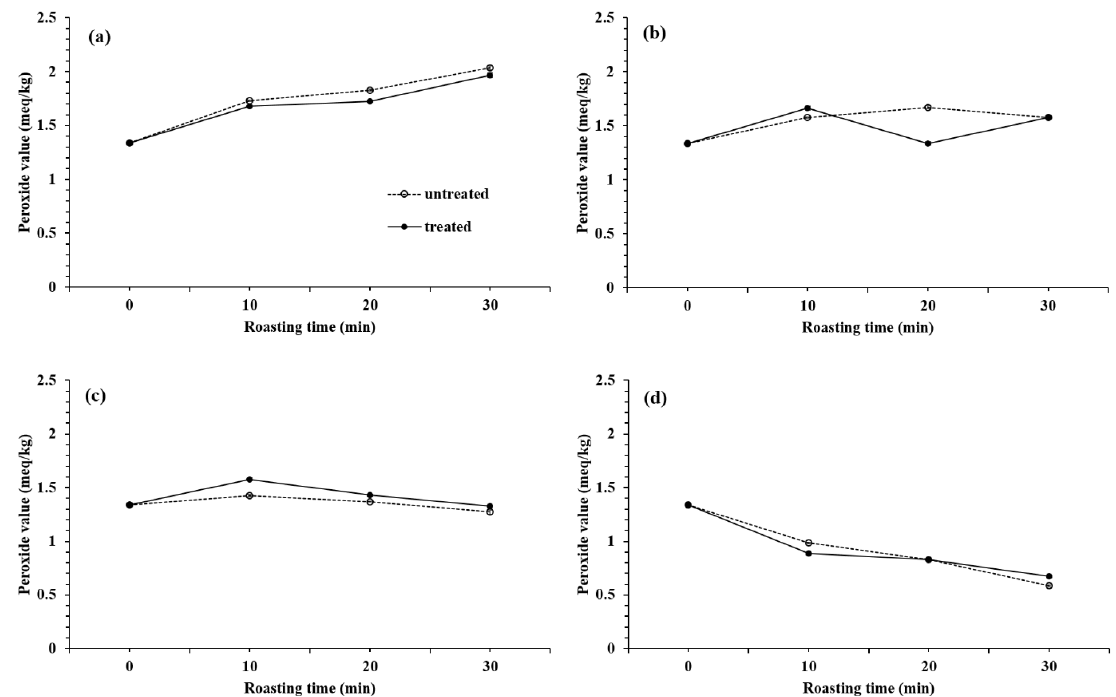
Figure 4. Peroxide value of sesame oil treated with and without 1% of the eulalia-based cellulosic aerogel under different roasting conditions; 150 °C ( a ), 180 °C ( b ), 210 °C ( c ), and 240 °C ( d ).